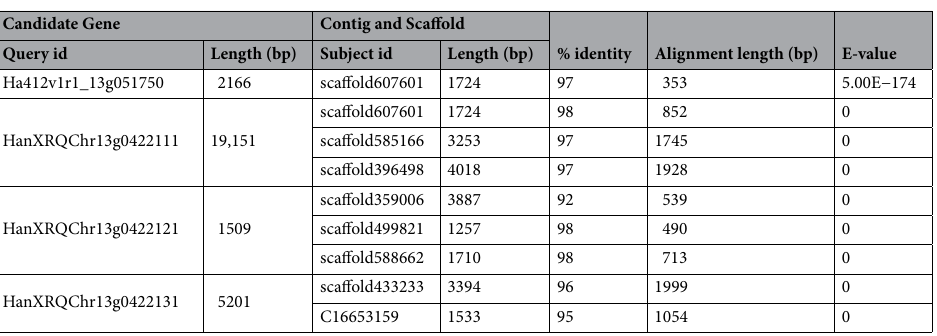
Table 6. Summary of the sequence identify between the R 11 candidate genes and selected scaffolds and contigs from the HA-R9 whole-genome resequence.